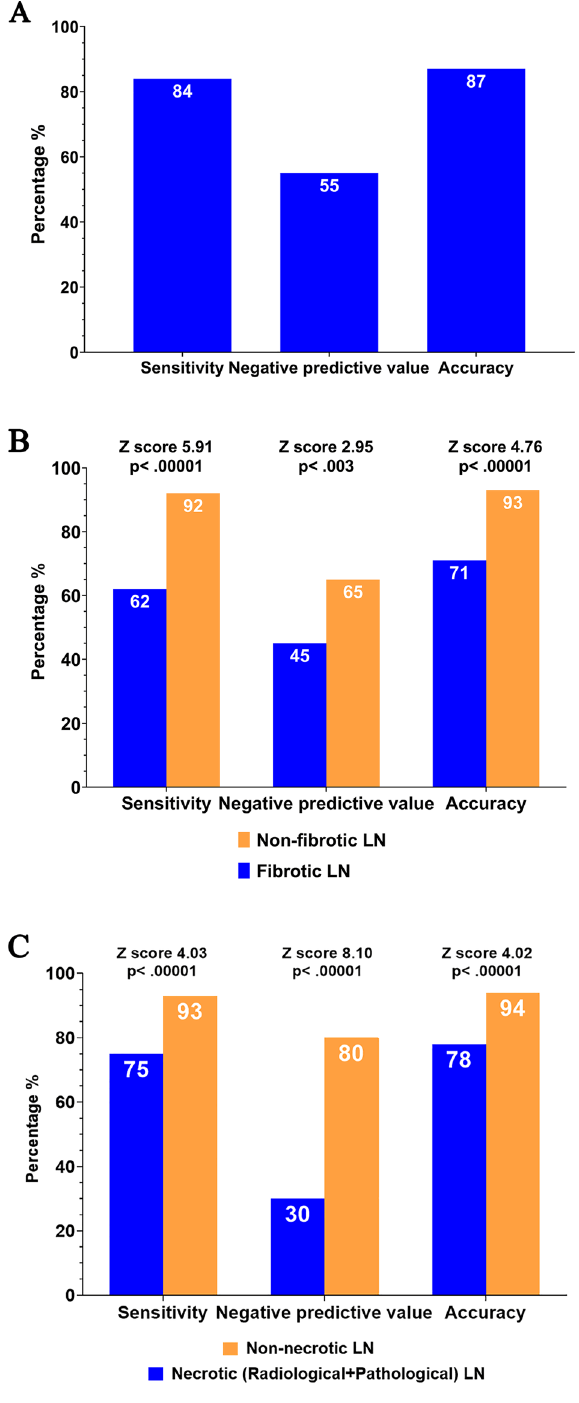
Figure 1. The sensitivity, negative predictive value, and accuracy of ( A ) core-needle biopsy (CNB) in patients with treated head and neck squamous cell carcinoma, overall; ( B ) CNB for the lymph node (LN) with and without fibrotic LN; and ( C ) CNB for the LN with and without necrotic